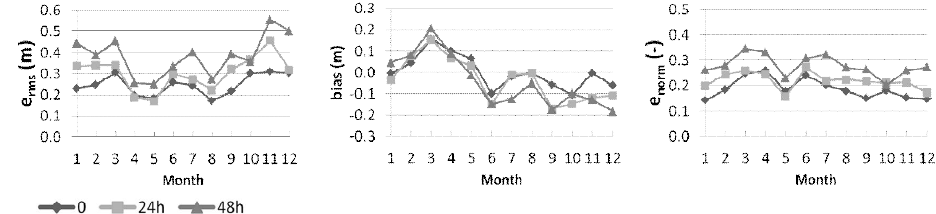
Figure 15. Monthly error of significant wave height H s for different HIRLAM input. Location: K13